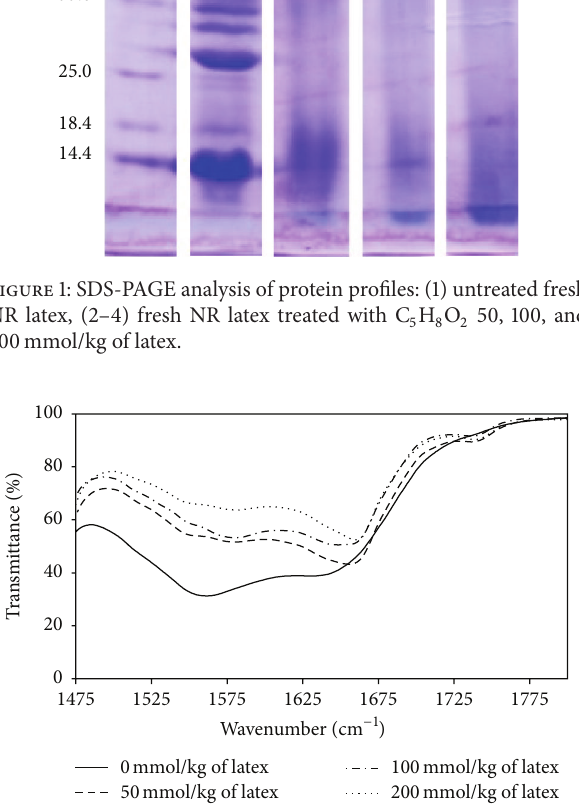
Figure 2: ATR-IR spectra of NR films obtained from untreated and treated fresh NR latex.